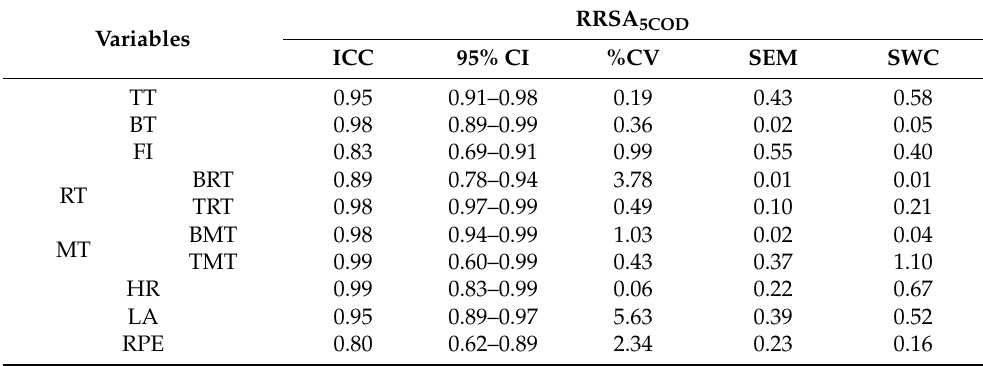
Table 2. Test/re-test reliability of the reactive multidirectional repeated sprints